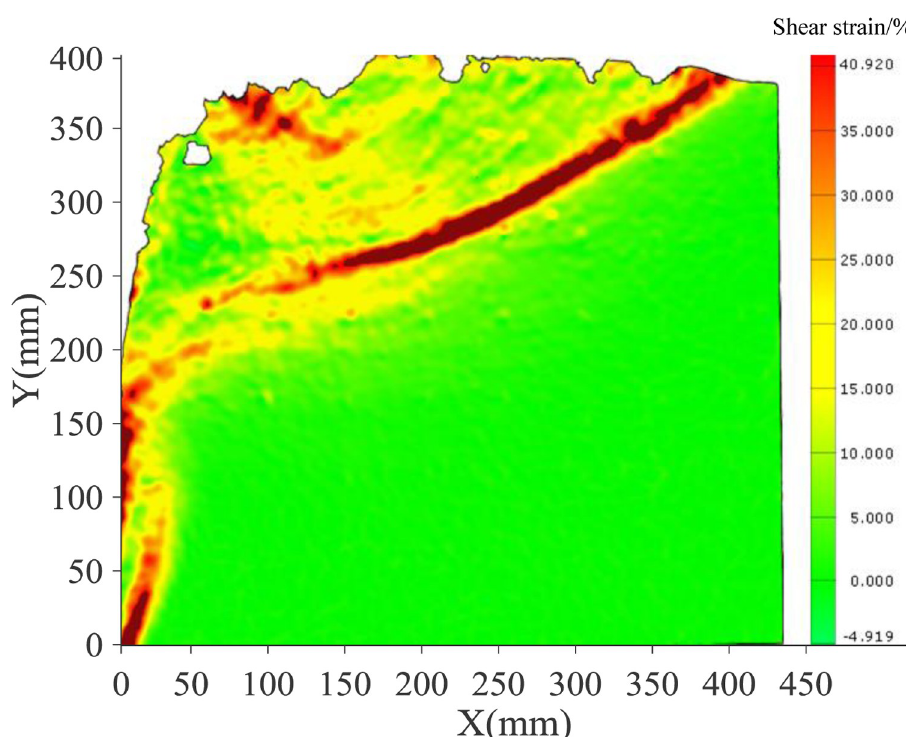
Fig 10. Nephogram of shear strain in final state